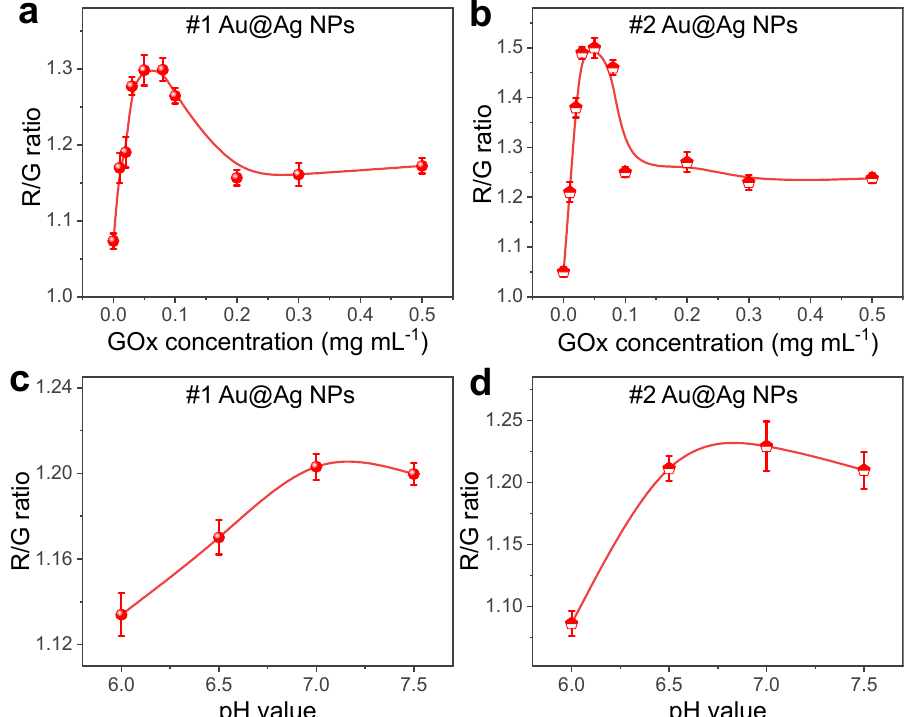
Figure 3. Optimization of GOx concentration and pH value for glucose sensing. ( a , b ) The changes in R/G ratio after sensing of glucose on ( a ) #1 and ( b ) #2 Au@Ag NPs with the presence of various concentrations of GOx. ( c , d ) The changes in R/G ratio after sensing of glucose on ( c ) #1 and ( d ) #2 Au@Ag NPs in solutions with various pH values.